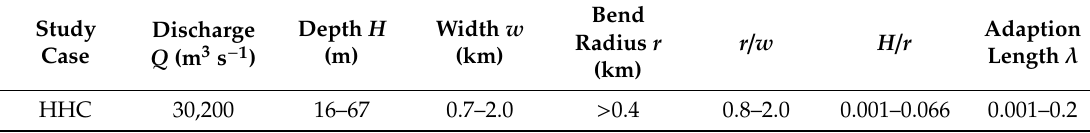
Table 3. Channel dimensions and flow condition of HHC reach.